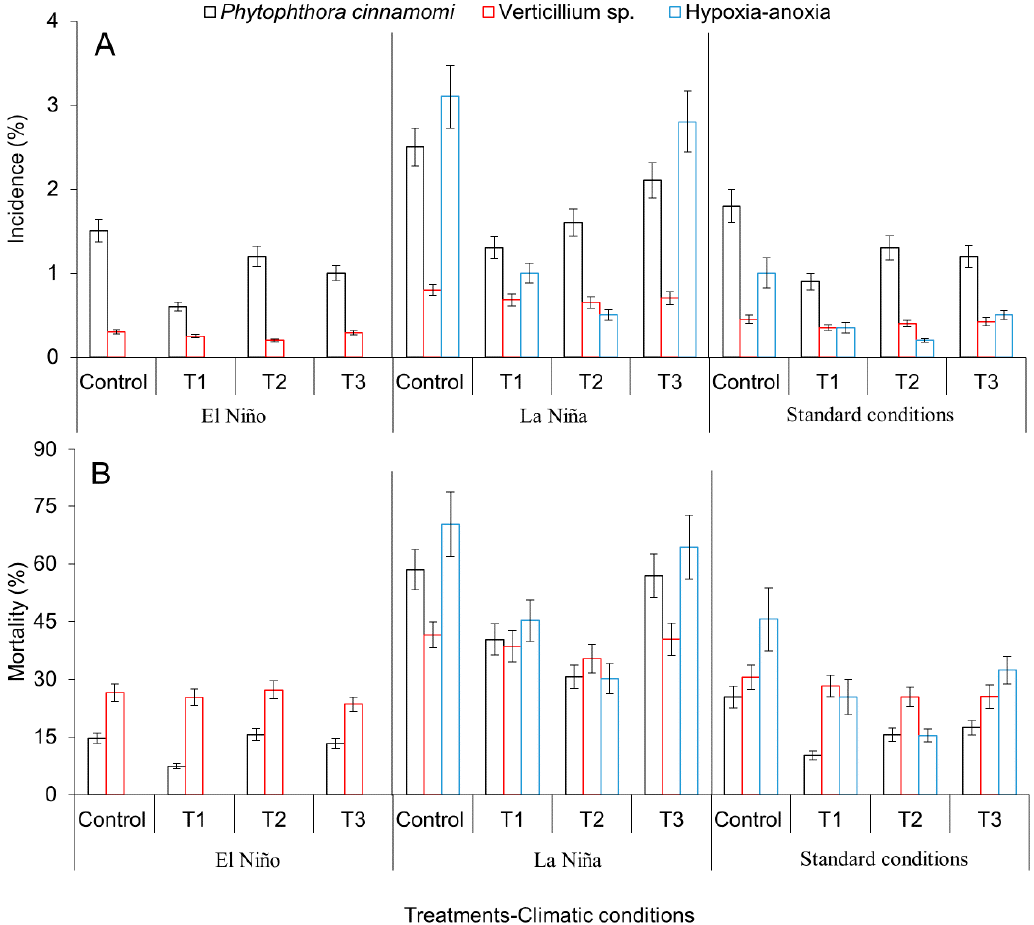
Figure 6. Variation in incidence ( A ) and mortality ( B ) values of avocado wilt disease induced by major causal agents after agronomical practices aimed to mitigate the adverse effects of the ENSO phenomenon (El Niño and La Niña) under field conditions. T1, new tools (plants with genetic identity, free of pathogen and root damage and planted under conditions of low alteration of the micro-drainage networks) implemented under field condition and the native genotype with the best performance to waterlogging, drought, graft compatibility, and resistance to P. cinnamomi and Verticillium sp.; T2, practices implemented in T1 + the native genotype with the best performance under waterlogging conditions; T3, practices implemented in T1 + the native genotype with the best performance under drought conditions; Control, traditional system implemented in avocado producing farms. Error bars represent the confidence interval of the mean, validated by Dunnett’s, and Tukey–Kramer separation tests. No overlapping of the error bars indicates significant differences ( p >0.05).